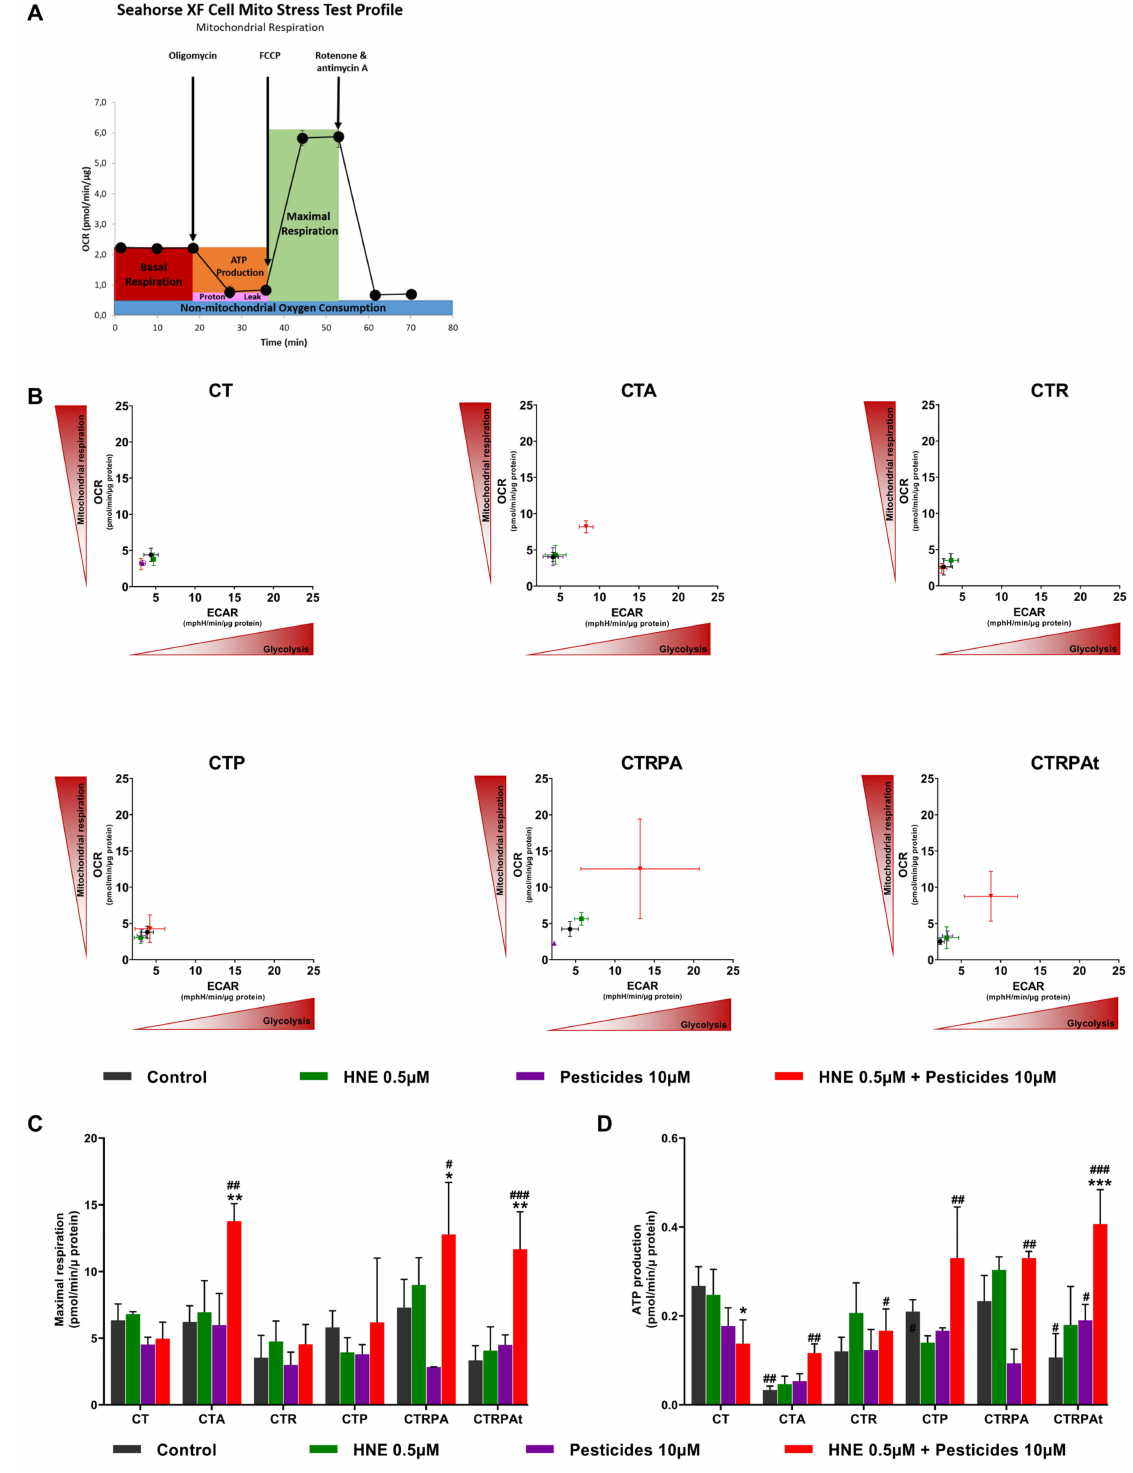
Figure 4. Metabolic reprogramming after three weeks exposure to contaminants in HCECs. ( A ) Agilent Seahorse XF Cell Mito Stress Test profile, showing the key parameters of mitochondrial function. ( B ) Quantification of basal Extracellular Acidification Rate (ECAR) and basal Oxygen Consumption Rate (OCR) using Seahorse ® after long term-exposure to contaminants in HCECs. ( C ) Maximal respiratory using Seahorse ® . ( D ) ATP production using Seahorse ® . All the results ( B – D ) represent the mean ± SEM of three independent experiments; statistical differences were analysed by post-hoc tests of a 2-way ANOVA model between control and treated cells (* p < 0.05, ** p < 0.01, *** p < 0.001) or between HCECs CT cells and others isogenic HCECs (# p < 0.05, ## p < 0.01, ### p <